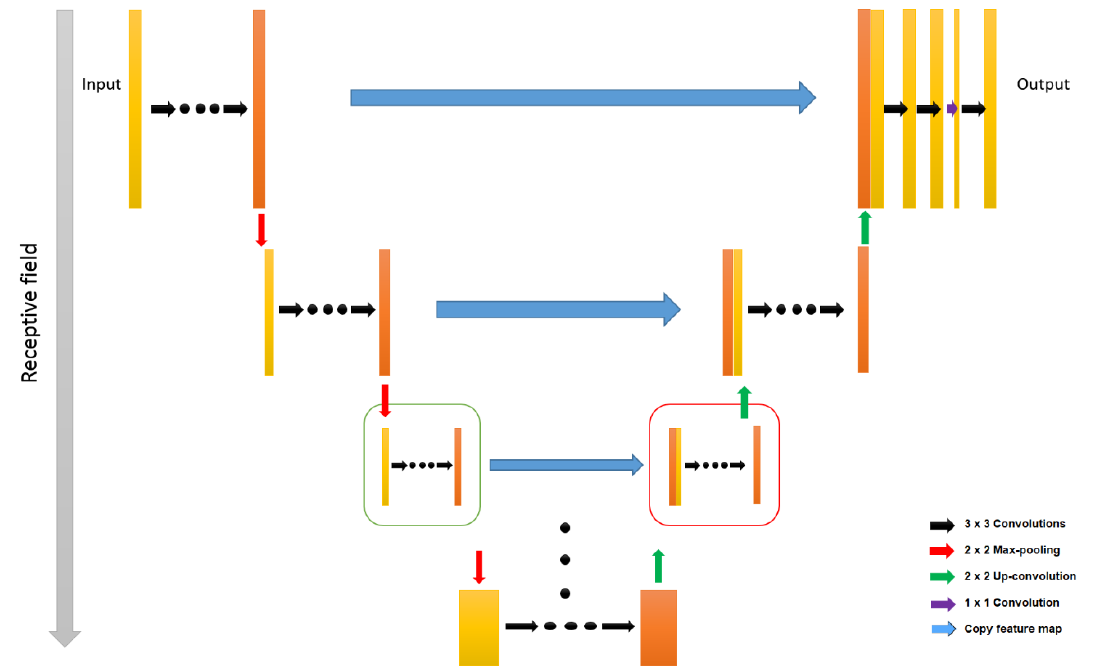
Figure 2. Schematic representation of a U-net architecture. Left-hand side box indicates the basic down-sample and right-hand side box indicates the up-sampled units. Modified after Venhuizen et al. [89].